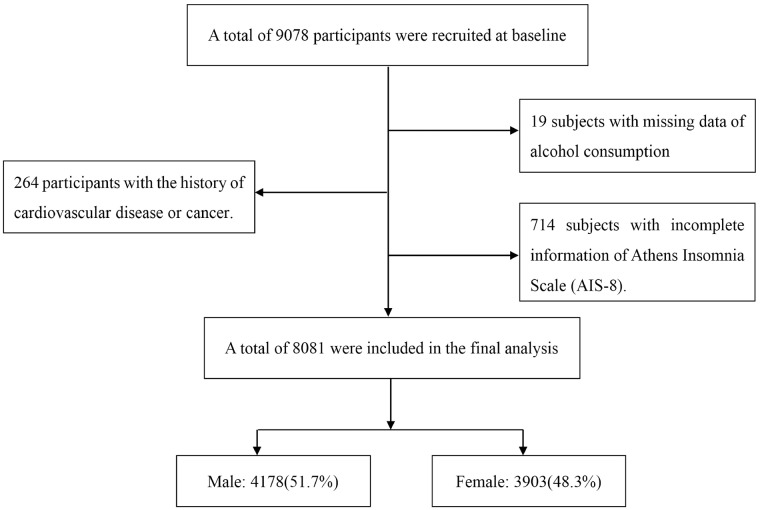
Flow chart of subjects with different exclusion criteria in this study.